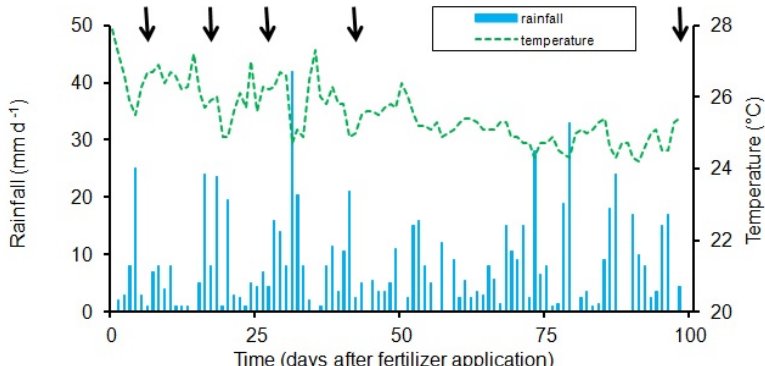
Figure 2. Rainfall and air temperature after the application of the 15 N fertilizer at flowering (10 October 2004, Day 0). Arrows indicate the dates of soil sampling. The last soil sampling was carried out at harvest (16 January 2005, Day 98).